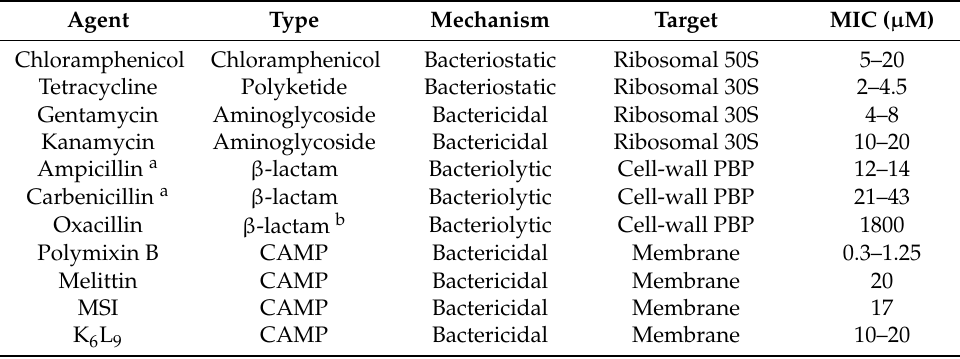
Table 1. Antibacterial agent properties and tested bMIC ranges concentrations.